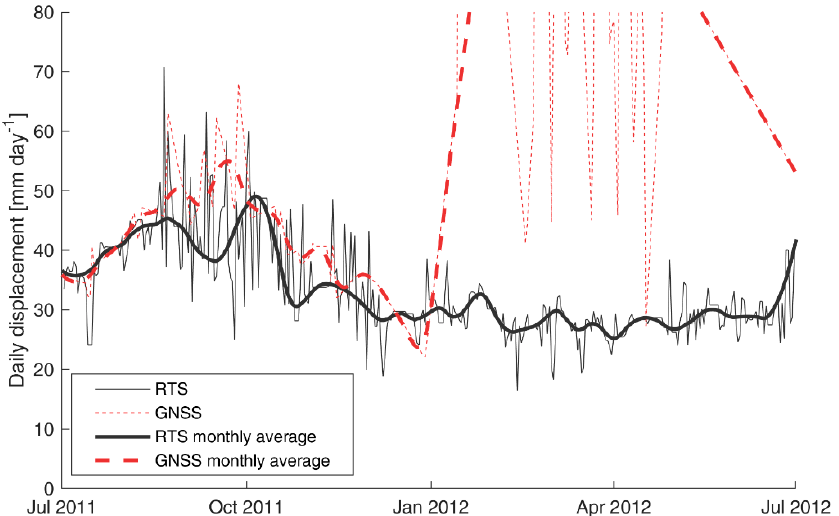
Figure 4. Whymper Serac’s daily surface 3D displacement measured by GNSS (dashed red line) and RTS (solid black line). Thick lines refer to the monthly averages. The displacement values are the averaged values of the available three GNSS and three to five RTS measured prisms.